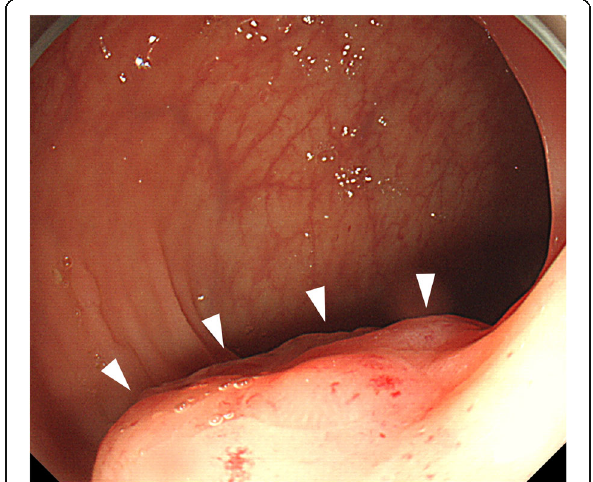
Fig. 3 Colonoscopy showing a superficial elevated lesion in the middle rectum